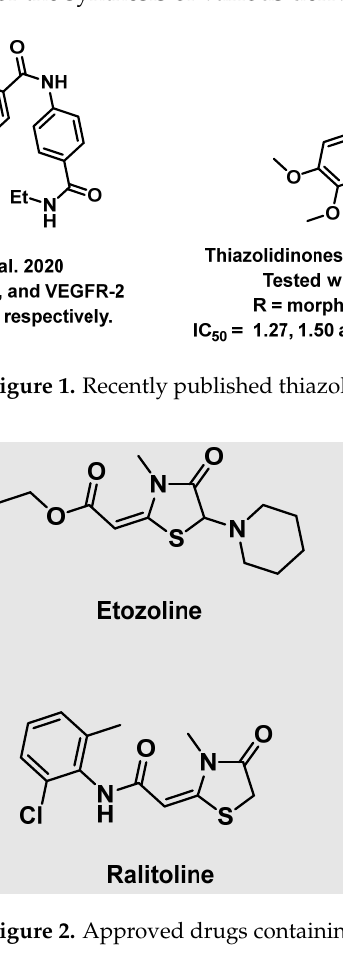
Figure 2. Approved drugs containing the thiazolidine core structure.